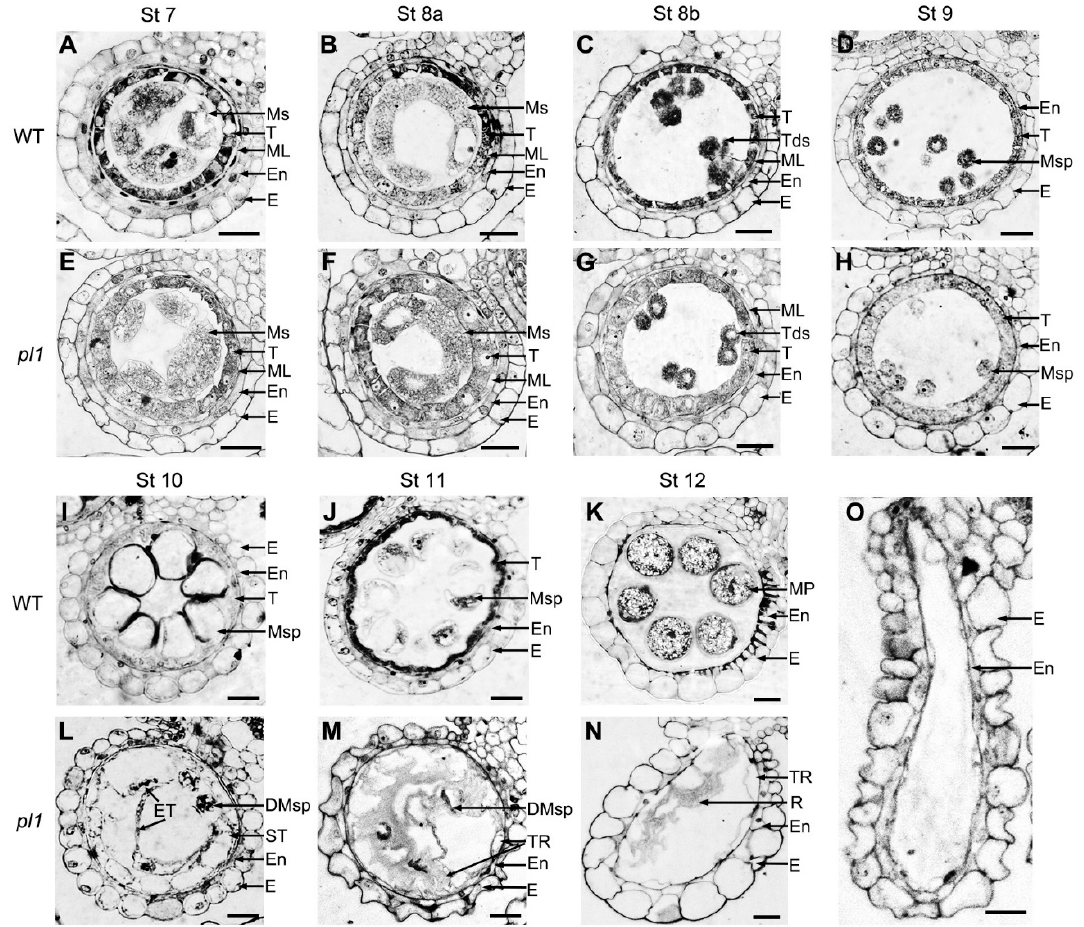
Figure 6. Cross-sections of anthers from stage (St) 7 to 12 in WT and pl1 . ( A–D ) and ( I–K ) WT anthers from St 7 to 12. ( E–H ) and ( L–N ) pl1 anthers from St 7 to 12. ( O ) pl1 anther with an empty locule at stage 12. DMsp, degrading microspores; E, epidermis; En, endothecium; ET, ectopic tapetal cells; ML, middle layer; MP, mature pollen; Ms, microsporocyte; Msp, microspores; R, remnants; ST, swollen tapetal cells; T, tapetum; Tds, tetrads; TR, tapetal remnants. Bars = 25 µm.